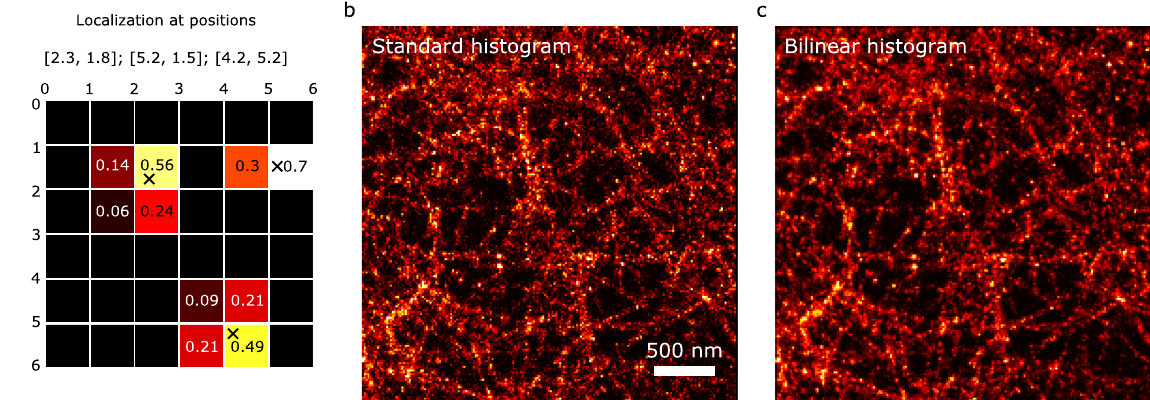
Fig. 1 Illustration of bilinear rendering of localization microscopy data. a Schematic of the rendering of localizations with positions [2.3, 1.8], [5.2, 1.5], [4.2, 5.2] (black crosses) on the image grid, with the weights indicated. b Standard histogram rendering applied on the center region (pixel size of 15 nm; FOV of 3×3 µ m) of the cSir Phalloidin dataset (see Fig. 2 for details). c Bilinear histogram rendering of the same region as in b . Scale bar 500